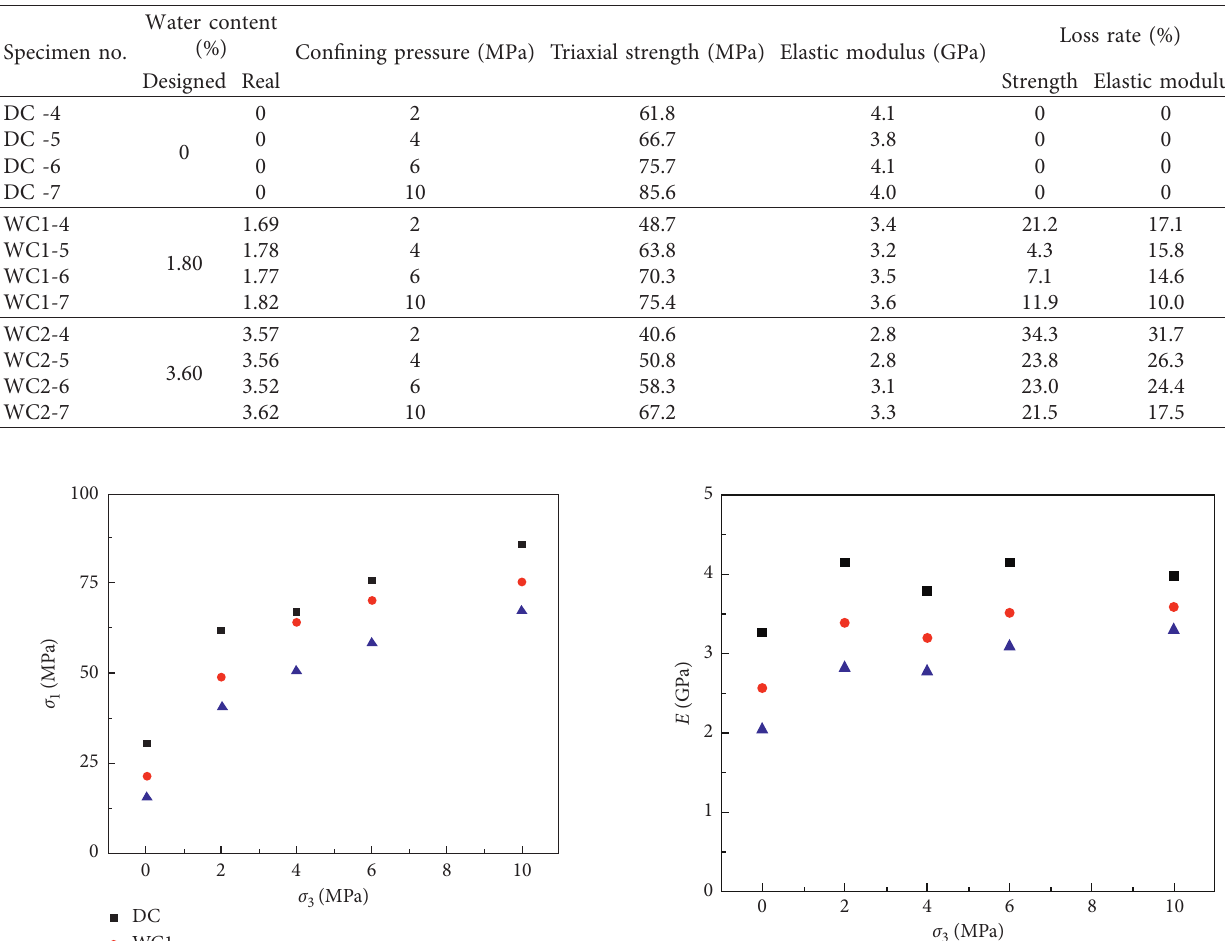
Table 3: Mechanical parameters of specimens under triaxial compression.